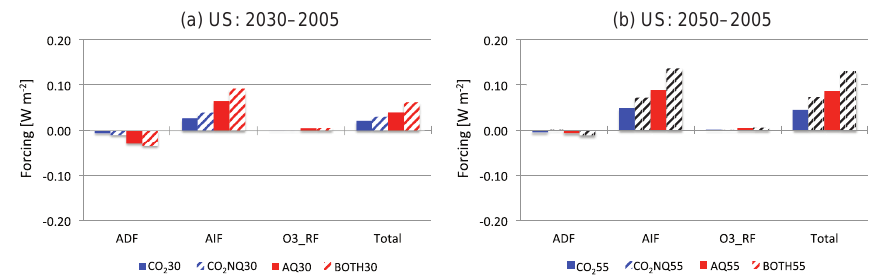
Figure 13. Impact of future warm climate conditions on US averaged radiative forcings in (a) 2030 and (b) 2055 relative to 2005. Note that BC albedo forcing is added into aerosol direct forcing (ADF).